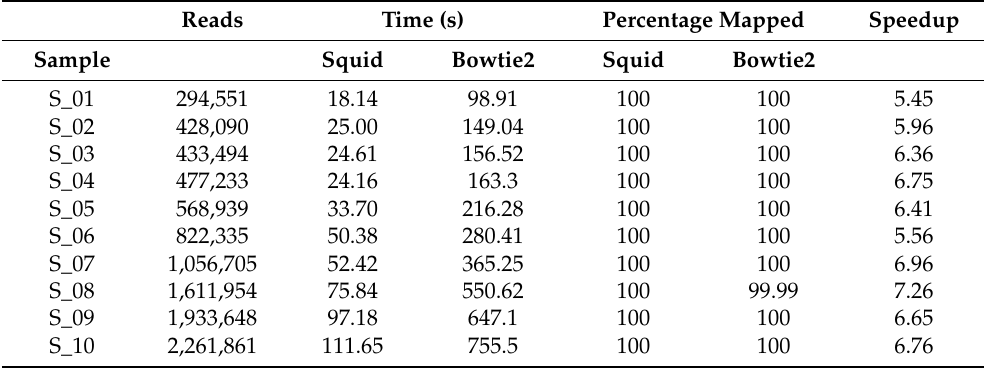
Table 1. Squid’s performance compared to Bowtie2 . The average reported speedup is 6.24; both programs were set to operate with a kmer length of 9 and step size of 1 nucleotide. Bowtie2 was set to ignore quality scores since Squid does not consider them in the current implementation. Moreover, a reporting value of k = 1 was selected in Bowtie2 to only report the first alignment found, and not look for multiple alignments. Squid library string “ − l IU” ensured that all of the inward orientations of the read pairs were to be